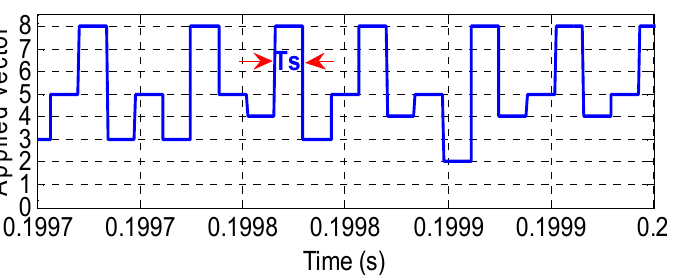
Figure 15. Steady-state performance of qZSI with modulated MPC with 22 vectors transitions during 0.0003 s in boosting mode at 20 μs : ( a ) optimal voltage vector in boosting mode, ( b ) duty in the shoot-through state, and ( c ) duty in the active state.